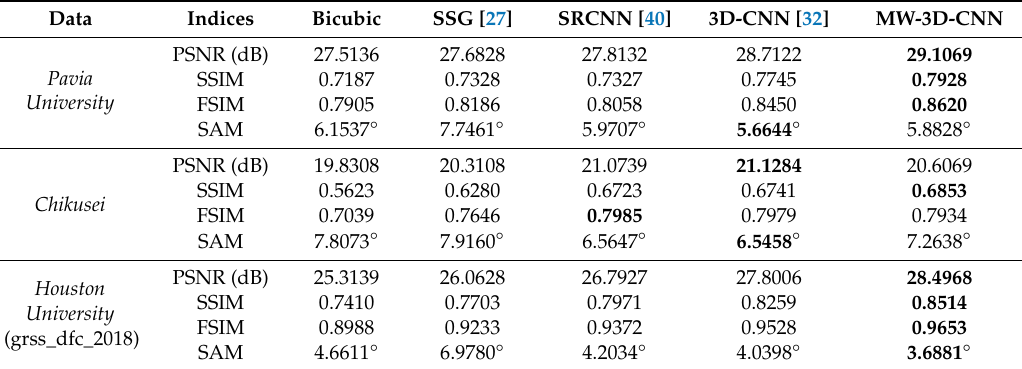
Table 2. The assessment indices of di ff erent HSI SR methods by an upscaling factor of four. Data